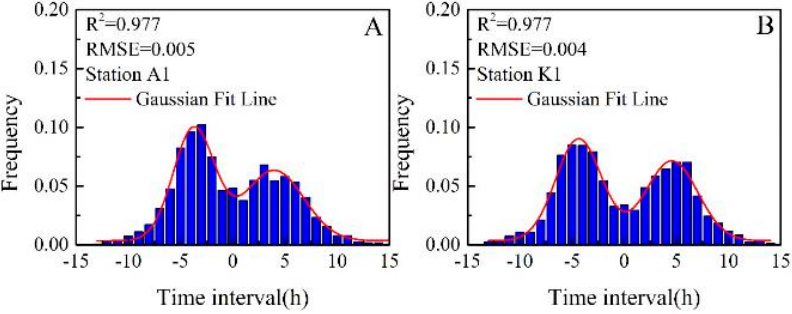
Figure 14. Time interval between the minimum SSC and the THW at stations A1 ( A ) and K1 ( B ) in 2007 and 2008.